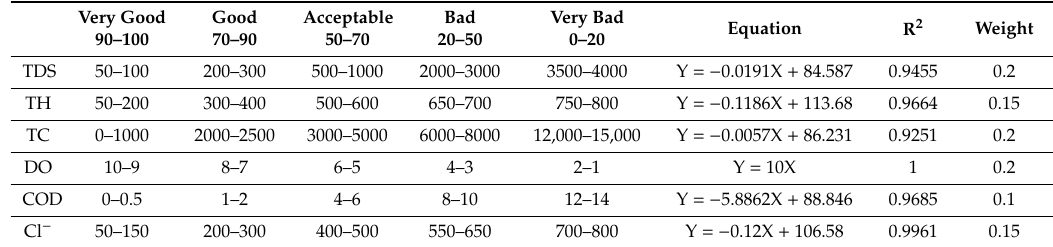
Table 3. Water quality categories proposed for Iraq water quality index (WQI), mathematical equations for function curves, and weights assigned for the six selected